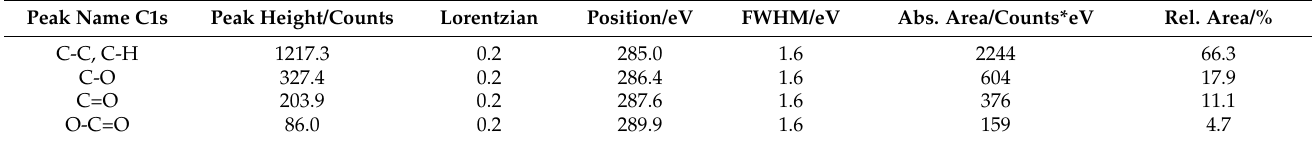
Figure 6. High-resolution C1s spectra of JRCNM62001a ( left ) and JRCNM62002a ( right ), with the corresponding fit parameters. Table 3. Fit parameters of the C1s of JRCNM62001a.